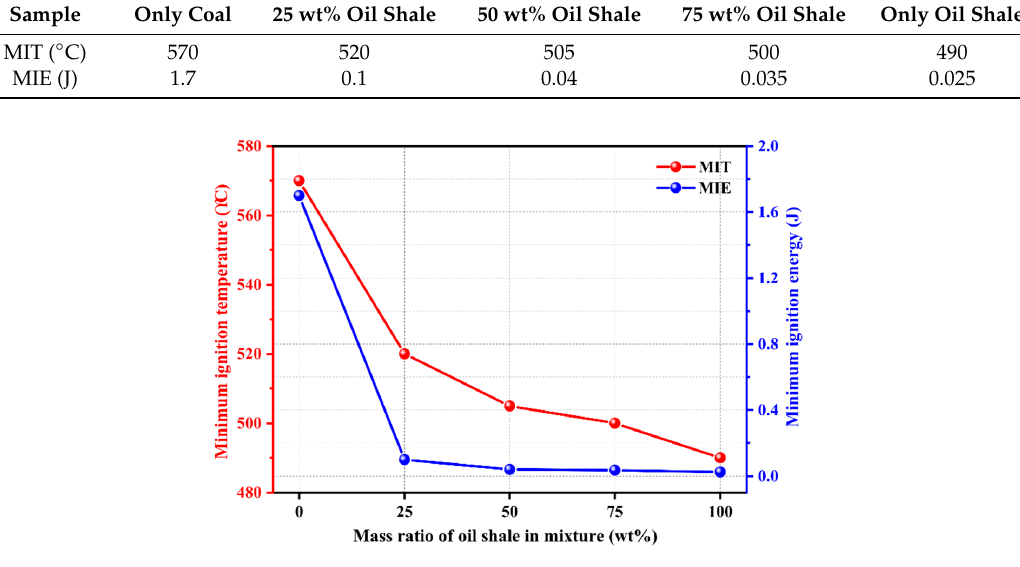
Figure 4. MIT and MIE curves of the dust cloud. Energies 2019 , 12 , x FOR PEER REVIEW